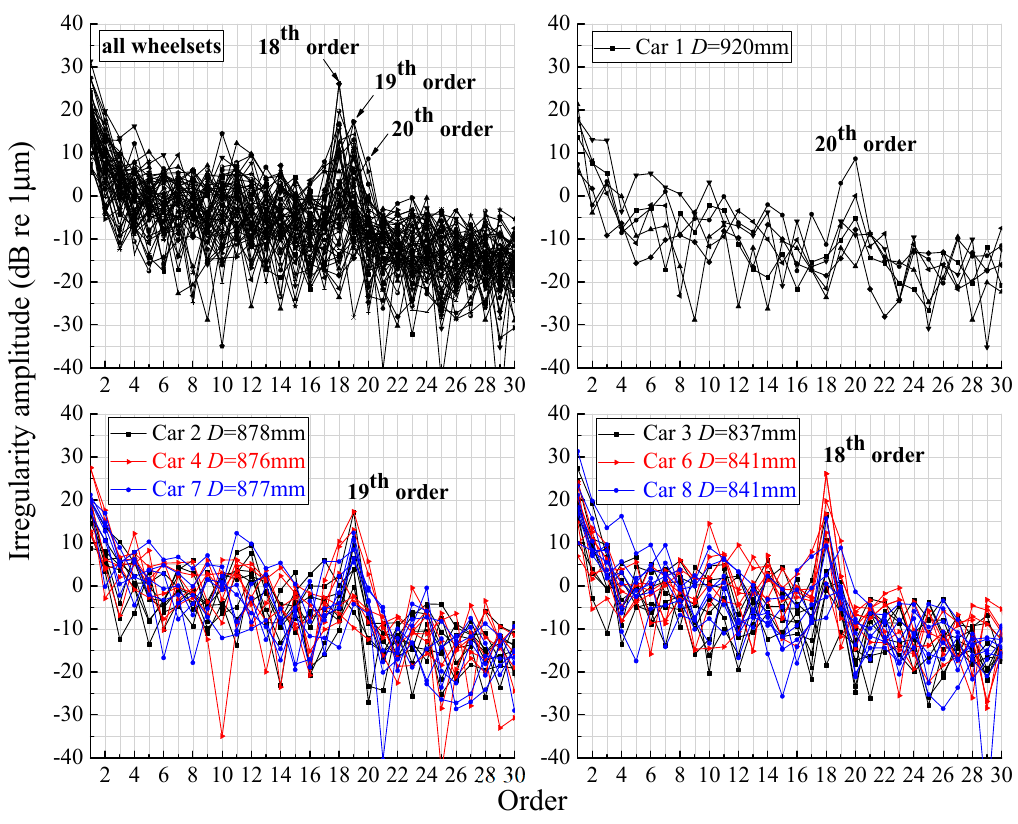
Figure 4. Results of the measured polygonal wear.